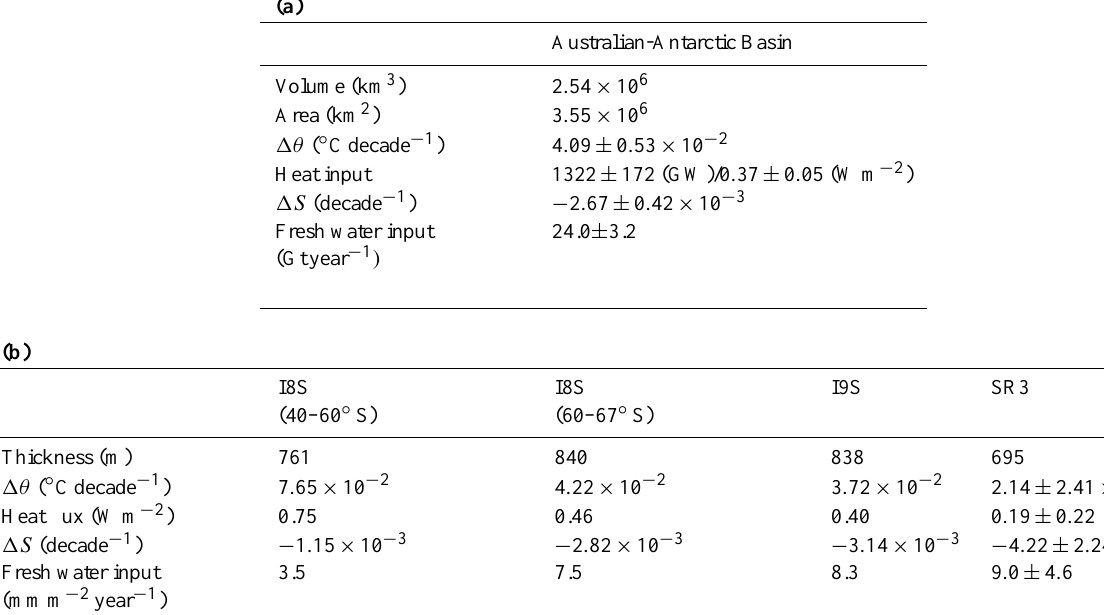
Table 2. Basin and section averaged trends in property of the AA-AABW. (a) Total volume of layers below γ n = 28 . 30kgm − 3 isopycnal, area of the Australian-Antarctic basin, mean potential temperature trend, required heat flux, mean salinity trend, required freshwater input in the Australian-Antarctic Basin. (b) Section averaged thickness of layers below γ n = 28 . 30kgm − 3 isopycnals, potential temperature trends, required heat fluxes, salinity trends, required freshwater inputs for respective sections. Error ranges for SR3 were derived from 95% confidence limit of linear regression